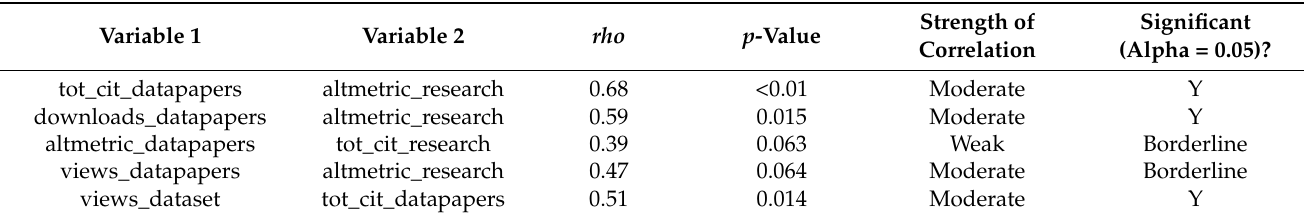
Table 5. Result of correlation analysis between the metrics of data papers and associated research papers and